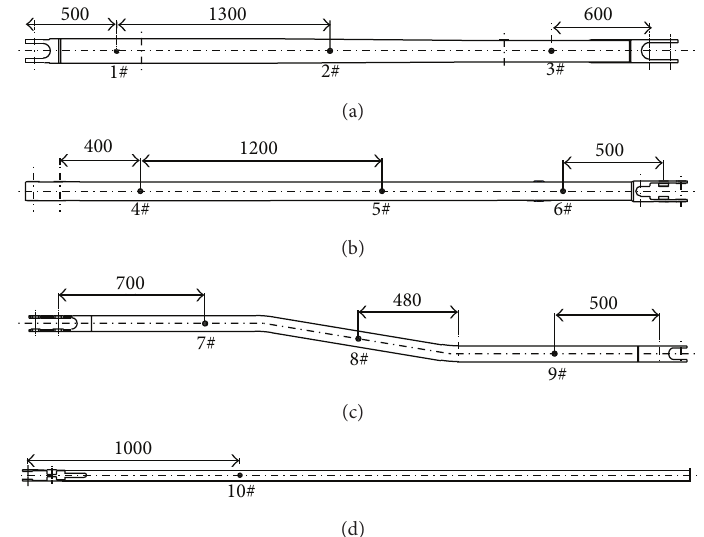
Figure 9: Strain sensors of the test points pasted on boom 1 (a), boom 2 (b), boom 3 (c), and boom 4 (d) during the experiment.